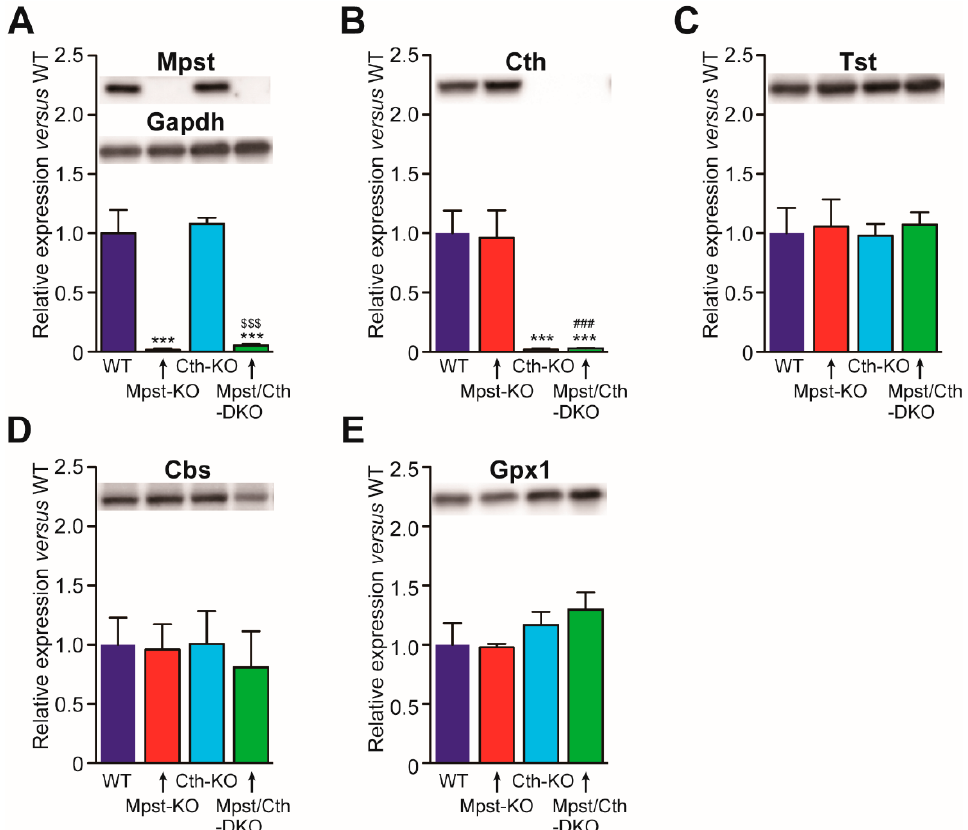
Figure 4. Hepatic expression of Mpst, Cth, Tst, Cbs, and Gpx1 in mice lacking Mpst, Cth, or both. Expression of Mpst ( A ), Cth ( B ), Tst ( C ), Cbs ( D ), and Gpx1 ( E ) in the livers of wild-type WT, Mpst (1st)-KO, Cth-KO, and Mpst (1st) / Cth-DKO mice was compared using Gapdh (A) as a loading control with that in WT liver as 1. Significant differences were observed versus WT mice at *** P < 0.001; Mpst (1st)-KO mice at ### P < 0.001; and Cth-KO mice at $$$ P < 0.001 ( n = 3).